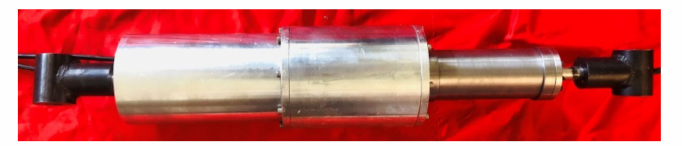
Figure 13. Prototype of self-powered MR damper.